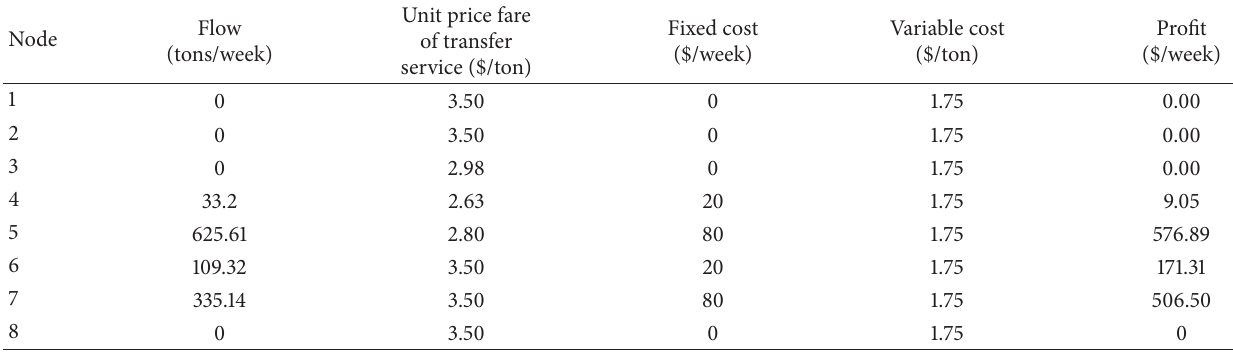
Table 6: Revenue and assignment of the transfer logistics